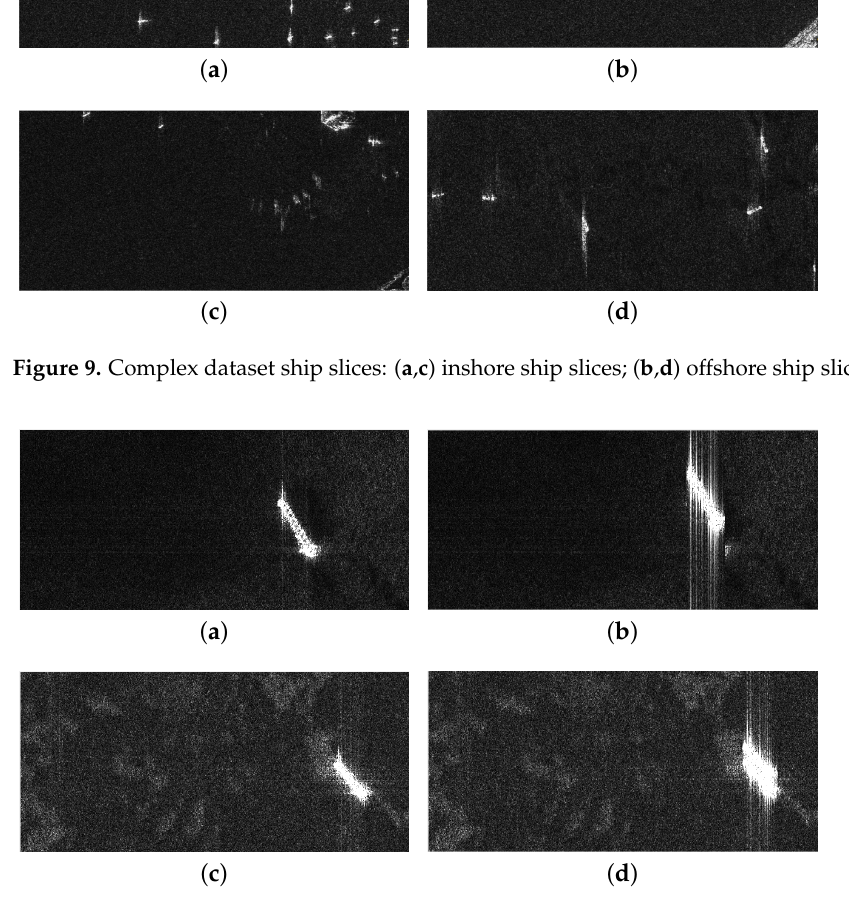
Figure 10. Defocused ship slices: ( a , c ) normal ship slices; ( b , d ) defocused ship